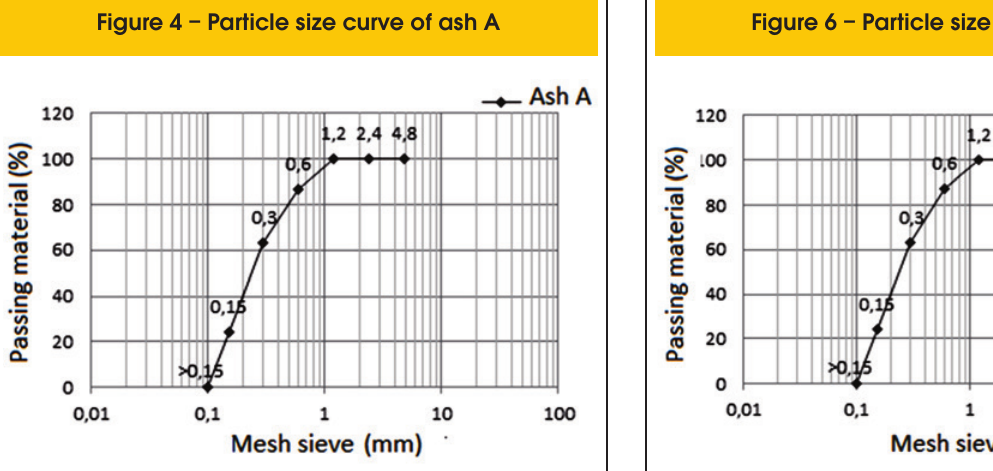
Figure 4 – Particle size curve of ash A